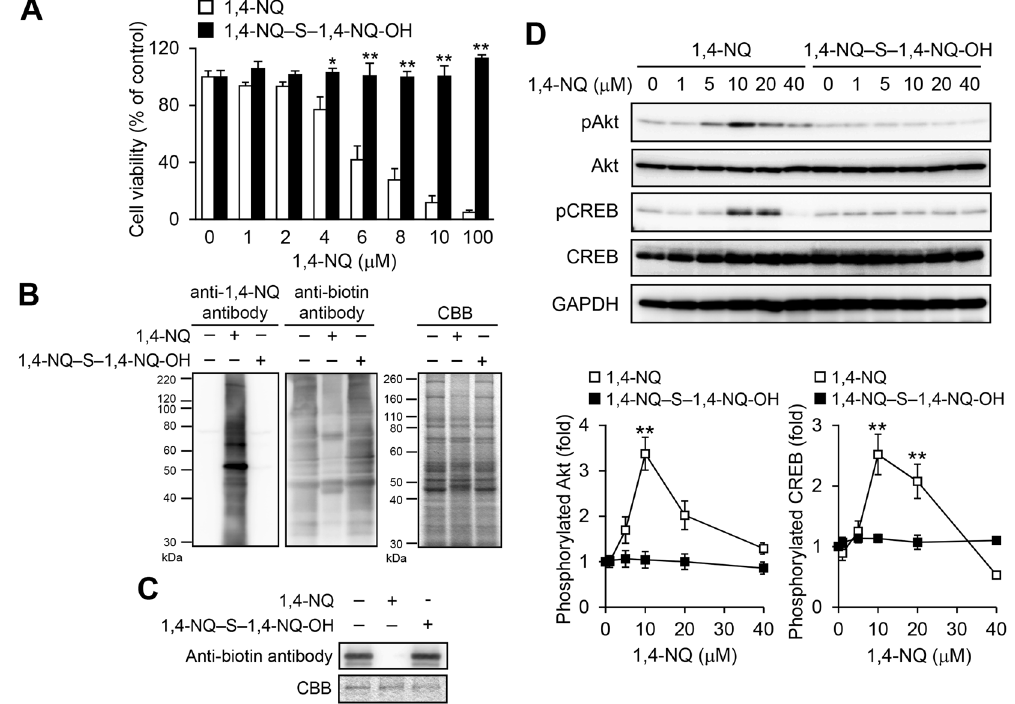
Figure 5. Cytotoxicity, covalent protein modification and Akt–CREB signaling activation caused by exposure of primary mouse hepatocytes to 1,4-NQ-sulfur adducts. ( A ) Primary mouse hepatocytes were exposed to 1,4- NQ or 1,4-NQ–S–1,4-NQ-OH for 24 h. Cell viability was determined with the MTT assay. Each value is the mean ± standard error for three independent experiments. ( B ) Cells were exposed to 1,4-NQ–S–1,4-NQ-OH (20 µ M) or 1,4-NQ (40 µ M) for 1 h. Covalent modification of cellular proteins with 1,4-NQ, as detected by western blotting (left), BPM assay results (middle) and protein bands on SDS-PAGE, as stained by Coomassie Brilliant Blue (right). Representative blots are shown from three independent experiments. ( C ) Recombinant GST-tagged human PTEN (1 μ g) was incubated with 1,4-NQ–S–1,4-NQ-OH (5 µ M) or 1,4-NQ (10 µ M) at 25 °C for 1 h and then further incubated with BPM (15 μ M) at 37 °C for 30 min. The reaction mixture was then analyzed by immunoblotting with the anti-biotin antibody and Coomassie Brilliant Blue was used to visualize bands after SDS-PAGE. Representative blots are shown from three independent experiments. ( D ) Cells were exposed to different concentrations of 1,4-NQ-sulfide for 30 min. Akt and CREB phosphorylation was determined by western blotting (upper). Representative blots are shown from three independent experiments. Band intensities were normalized to those for total Akt and CREB, respectively (lower). Intensities are expressed as fold induced, relative to results with 0 µ M 1,4-NQ exposure. Each value is the mean ± the standard error for three independent experiments. * P < 0.05 and * P < 0.01, compared with the 0 µ M 1,4-NQ exposure.